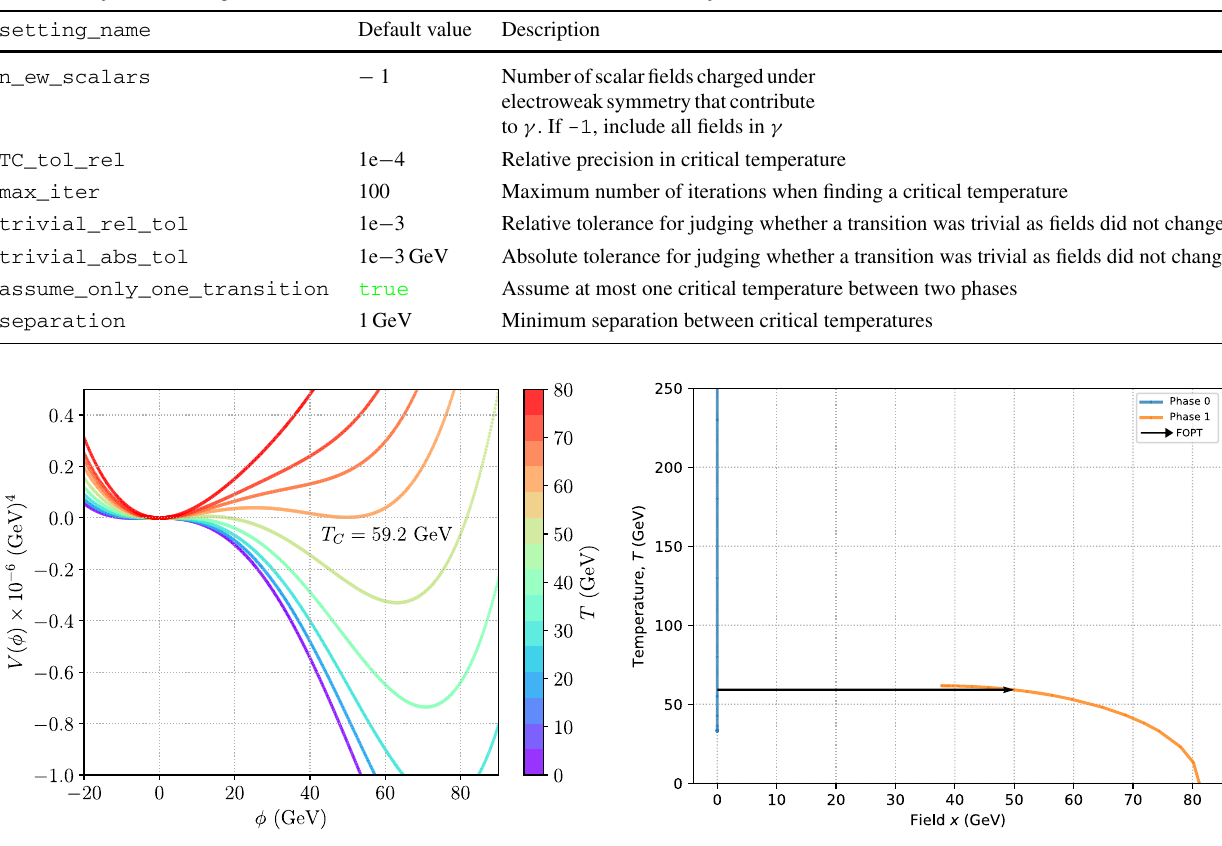
Fig. 2 The one-dimensional potential at different temperatures (left) and the subsequent phase structure of the model (right). On the right panel, the lines show the field values at a particular minimum as a func- tion of temperature. The arrows indicate that at that temperature the two